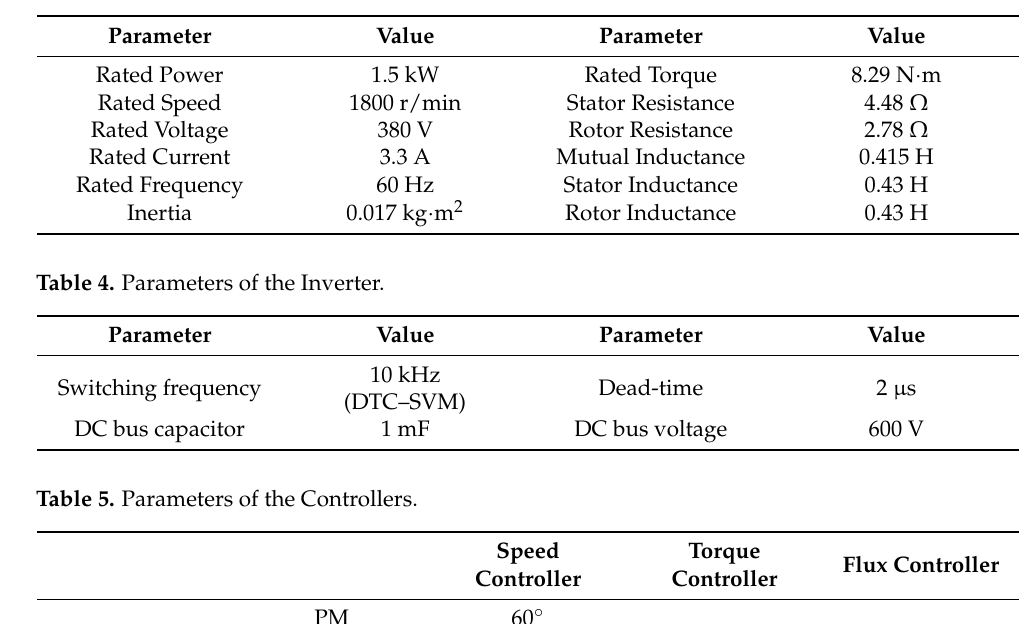
Table 3. Parameters of the Induction Motor.